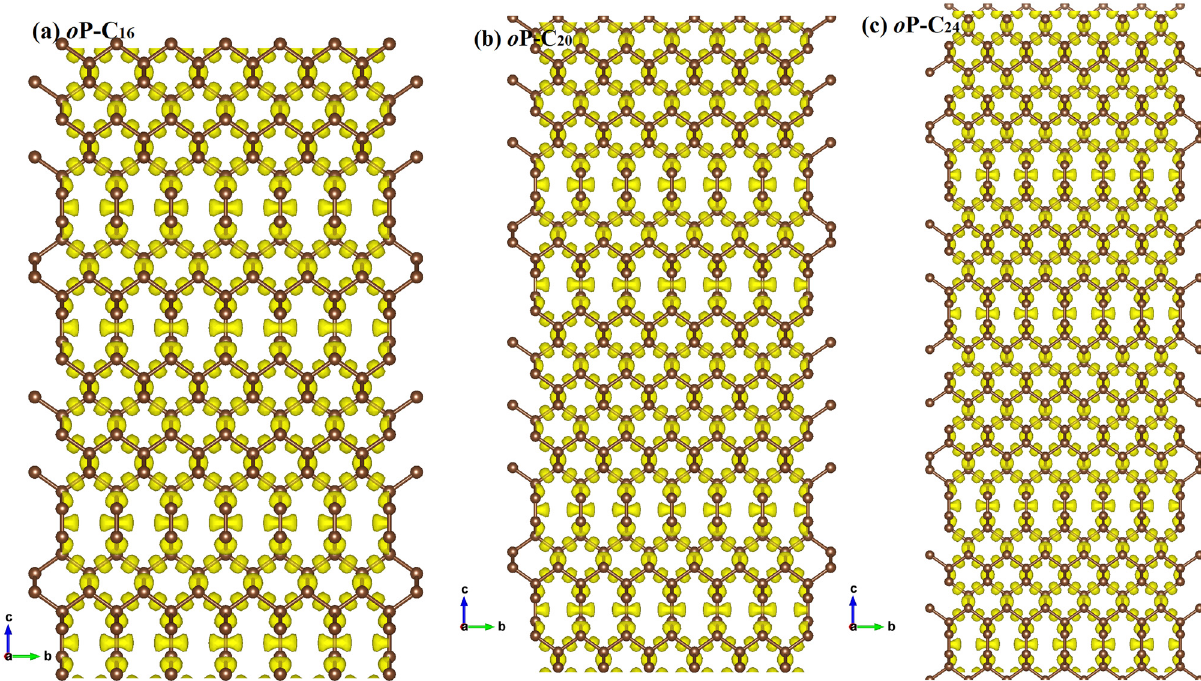
Figure 4: The electron localization function ( ELF ) of o P - C 16 ( a ) , o P - C 20 ( b ) , and o P - C 24 ( c ) with an isosurface level set to